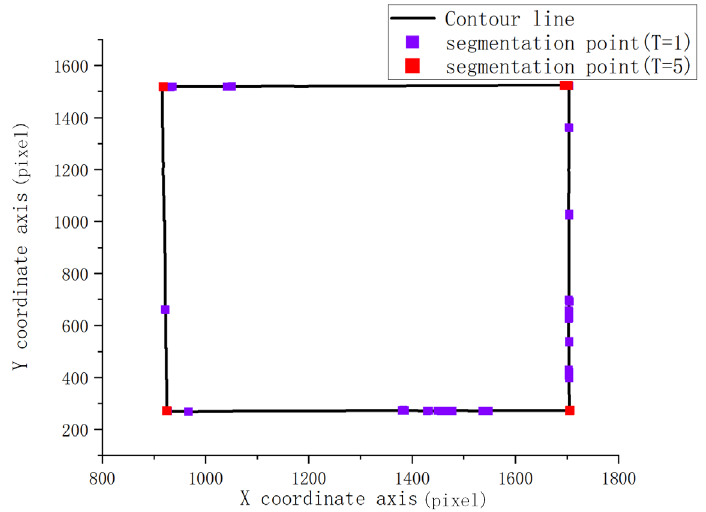
Figure 24. Noise suppression effect of NMS segmentation point selection.